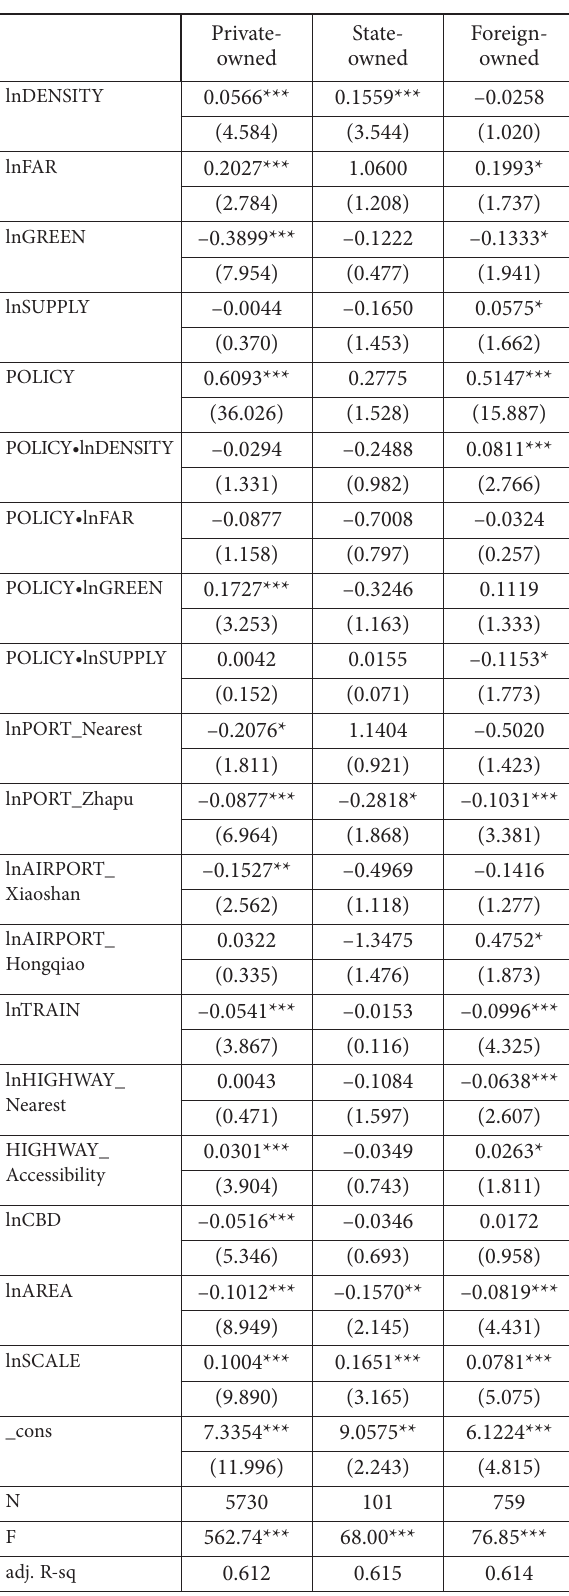
Table 4. Results of the regression model of the impact of land use regulation on industrial land price by ownership